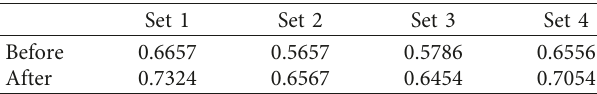
Table 2: Comparison of results of different data set before and after using optimization (data set 2).